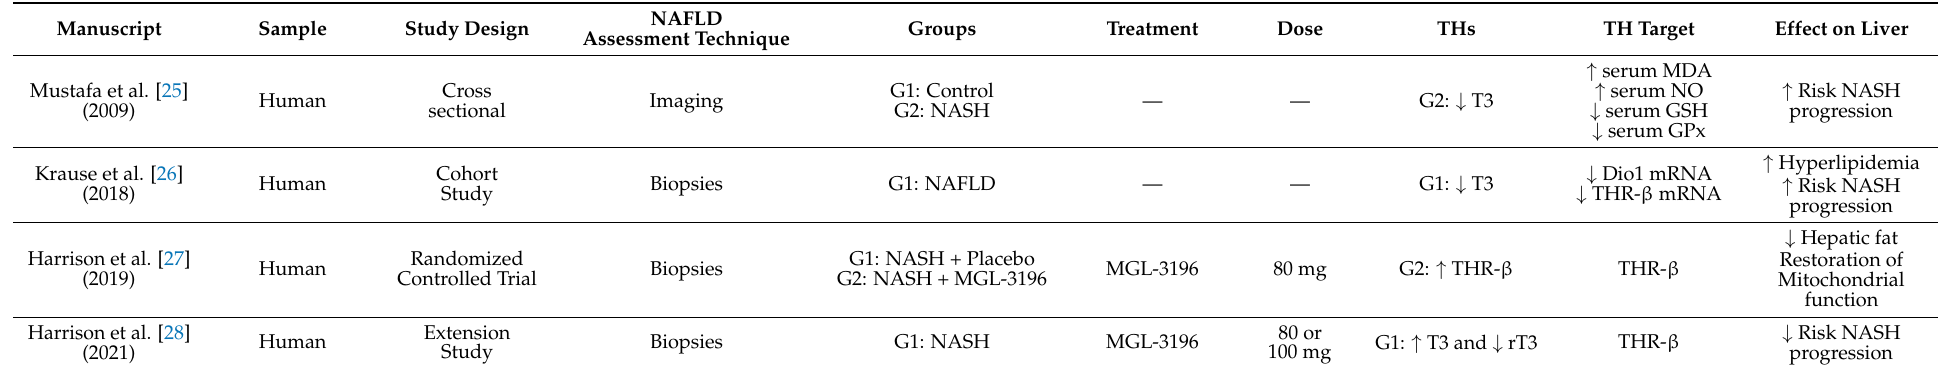
Table 2. Metabolic action modulated by thyroid hormone signaling in clinical studies.